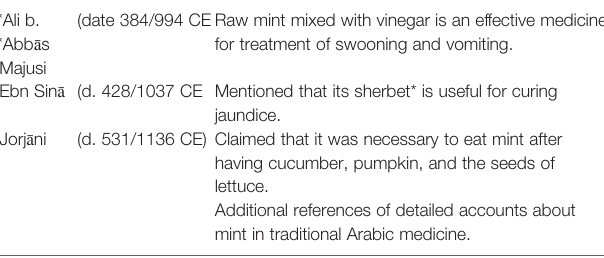
TABLE 2 | Application of mint in Arabic traditional texts. (Iranian encyclopedia online,